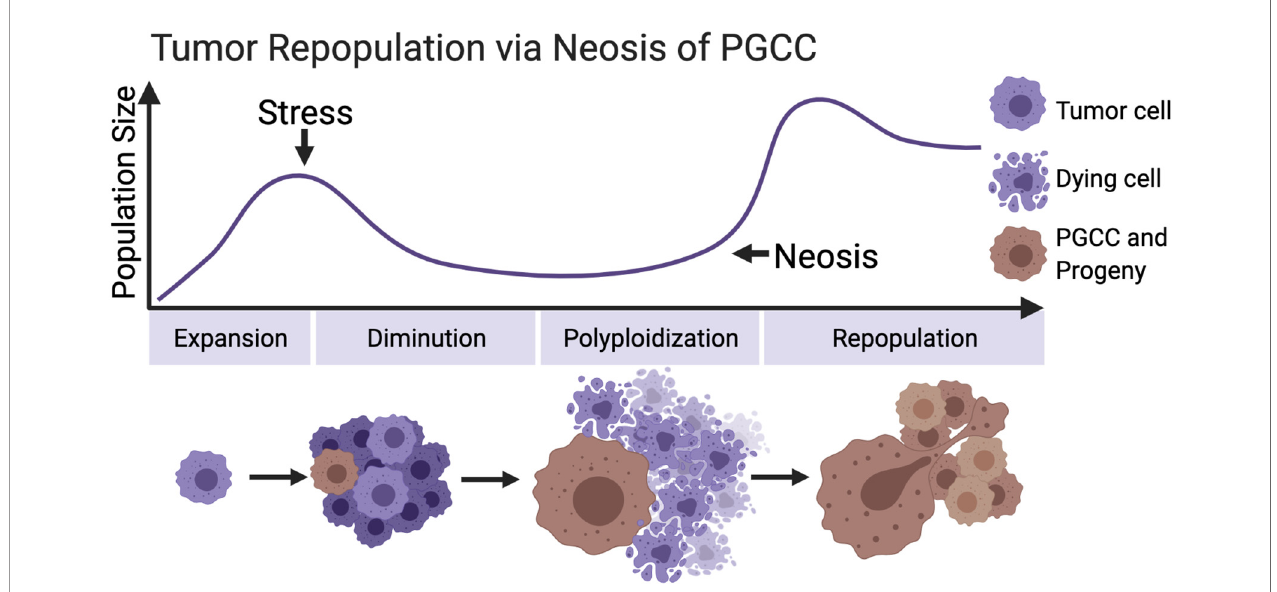
FIGURE 2 | Primitive model of tumor repopulation via neosis of PGCCs. When tumor cells proliferate to a certain scale for the fi rst time, they encounter treatment stress or other kinds of survival pressure. Most of the tumor cells are killed, while a small part of them survive and form PGCCs, containing the extensive potential to re-enter the proliferation cycle through neosis. (Created with